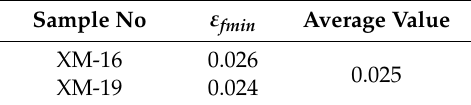
Table 6. Value of Parameter ε f min